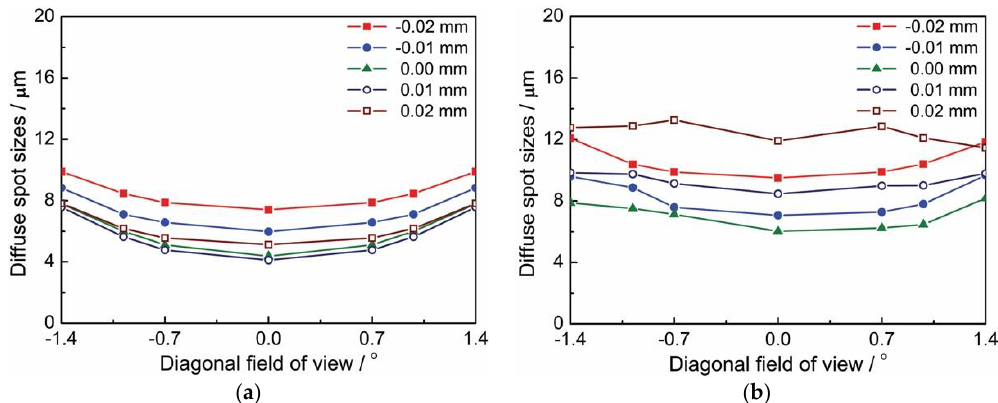
Figure 12. Diffuse spot sizes of the COS prototype by ( a ) theoretical calculations, ( b ) experimental measurements.